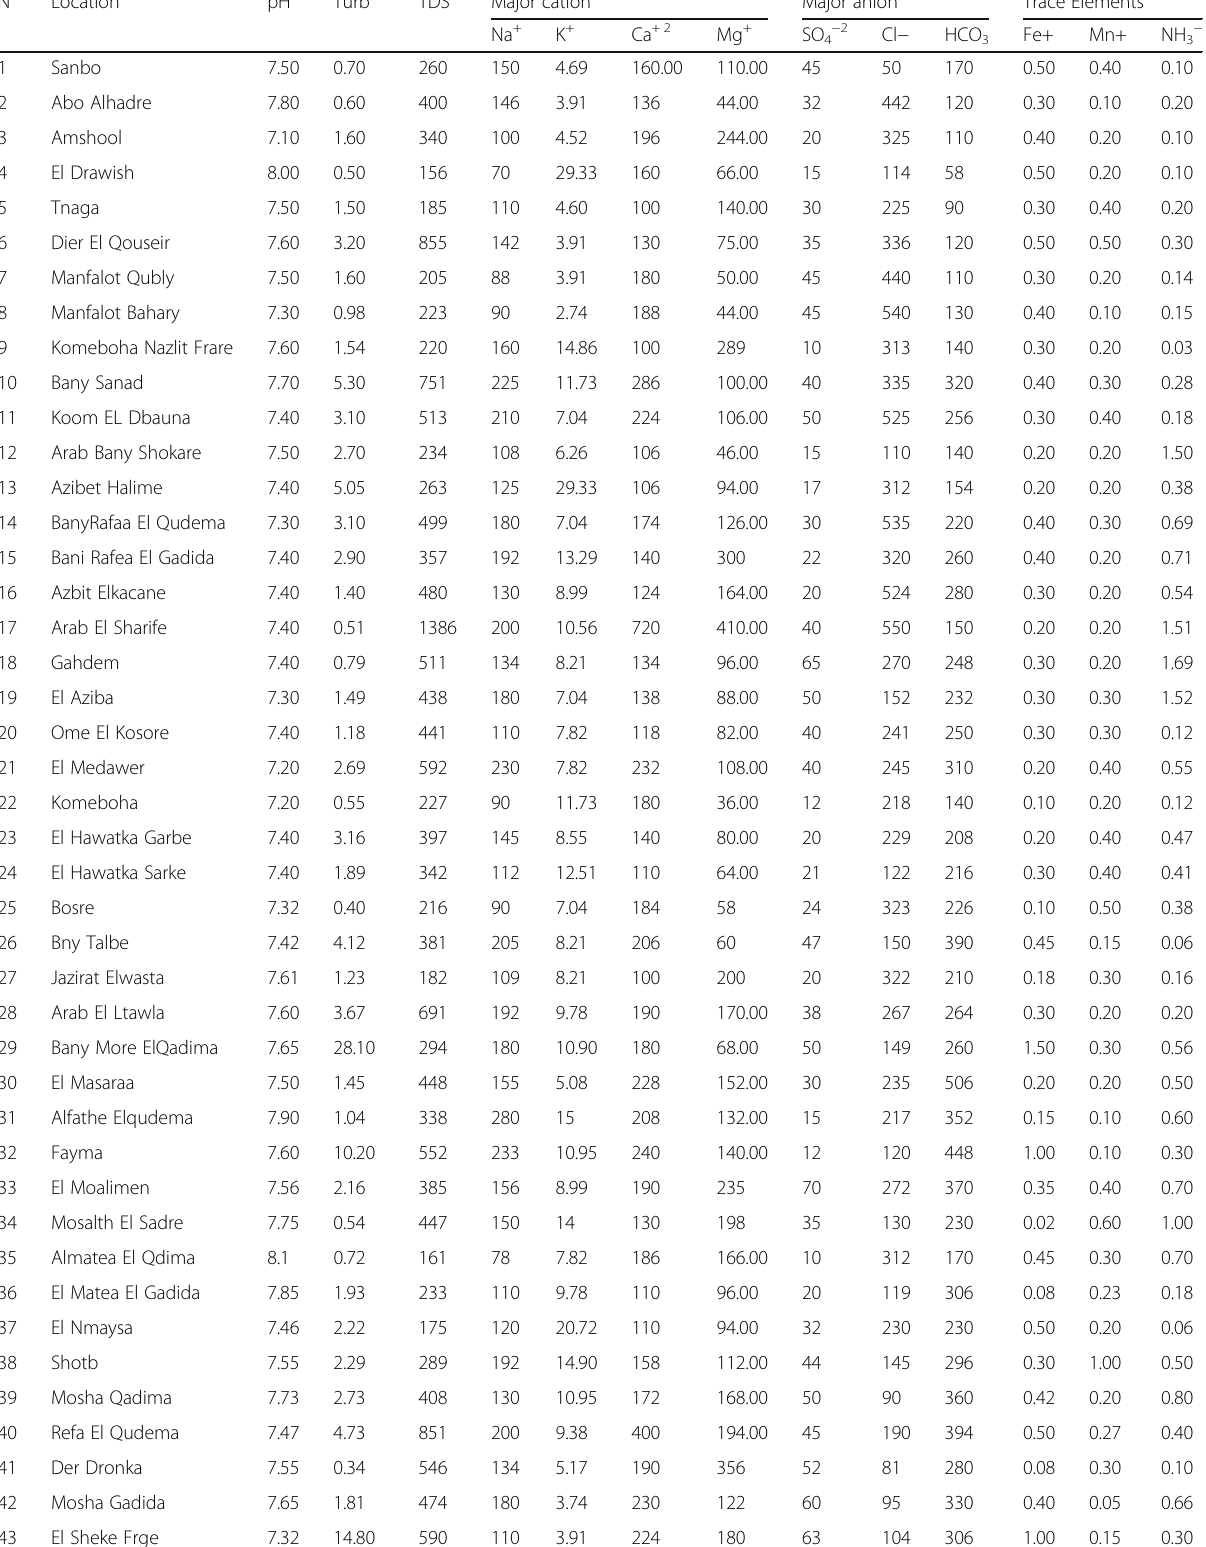
Table 4 Results of chemical analyses of studied groundwater samples in Assuit